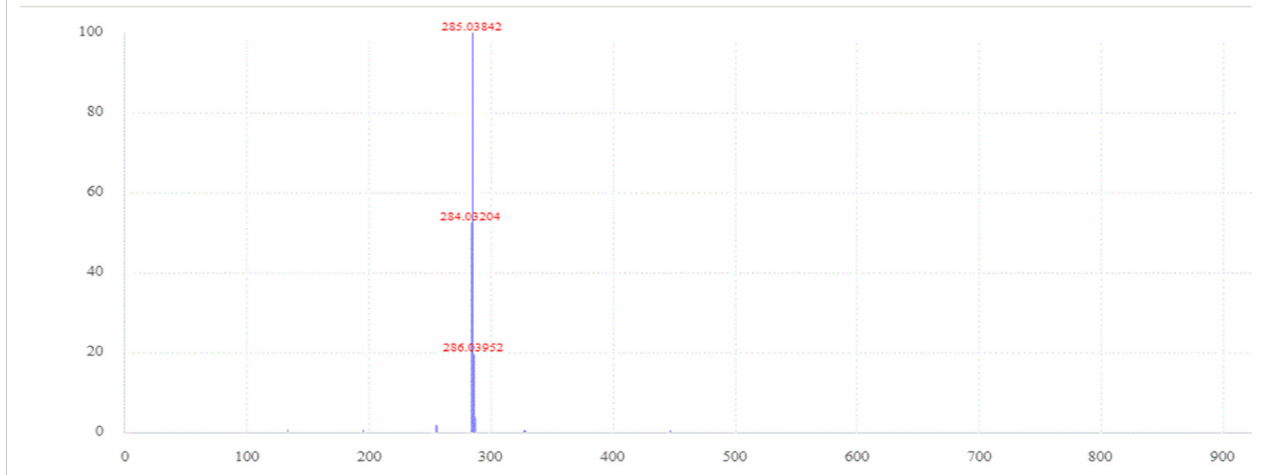
Figure 1. Identification procedure for luteolin glucoside isomers ( a ) EIC of m / z 447.0933 ( ± 0.005 mDa) in an olive sample; ( b ) Background subtracted MS spectrum from 5.3 to 5.4 min; ( c ) Molecular formula annotation of m / z 447.0933; ( d ) Background subtracted MS/MS spectrum from 5.3 to 5.4 min; ( e ) Background subtracted MS/MS spectrum from 6.0 to 6.1 min; ( f ) Background subtracted MS/MS spectrum from 6.3 to 6.5 min; ( g ) Structures of precursor and fragment ions of luteolin glucosides; ( h ) Riken Plant Specialized Metabolome Annotation (PlaSMA) Authentic Standard Library